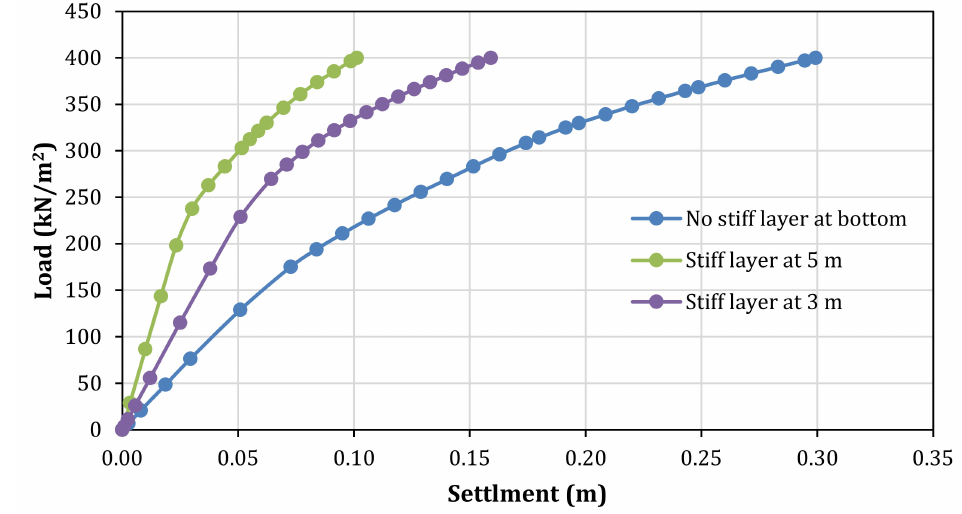
Figure 12. Effect of multi-layer soil profile on